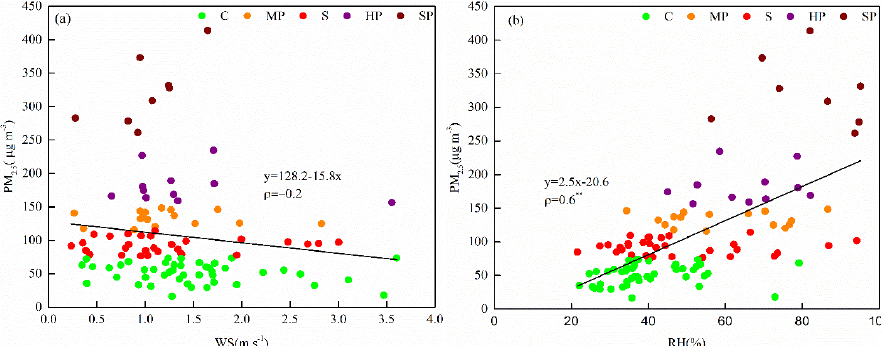
Figure 6. Relationships between PM 2.5 concentration and wind speed (WS, a ) and relative humidity (RH, b ) (note: ** indicates ρ < 0.01).